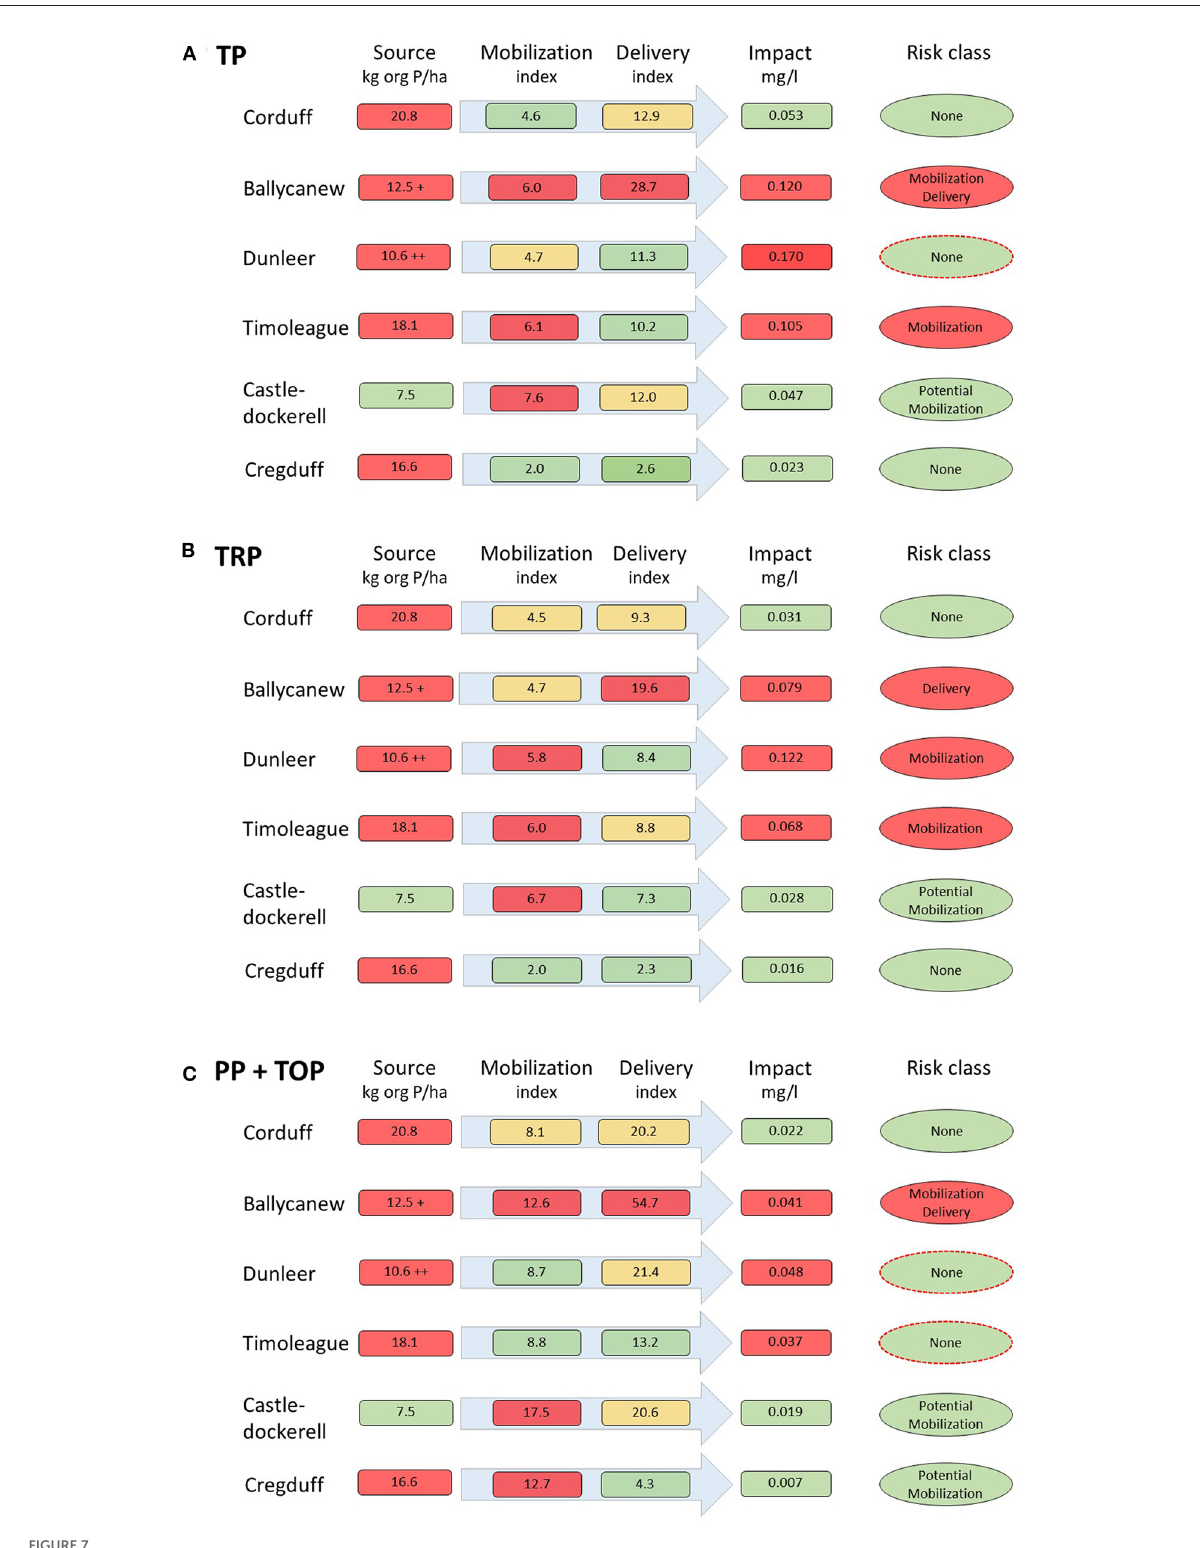
FIGURE7 The conceptual P transfer continuum model (Haygarth et al., 2005) populated with data on 10-year average P source, mobilization index , delivery index , P impact (mg/l) and indicated risk class for (A) TP, (B) TRP and (C) PP + TOP. Colour codes: Red, higher than median and average; yellow, near to median and average (within 10%); green, below median and average. The P source is based on average stocking rate. + indicate added organic manure by slurry and ++ indicates added organic manure by slurry and imported